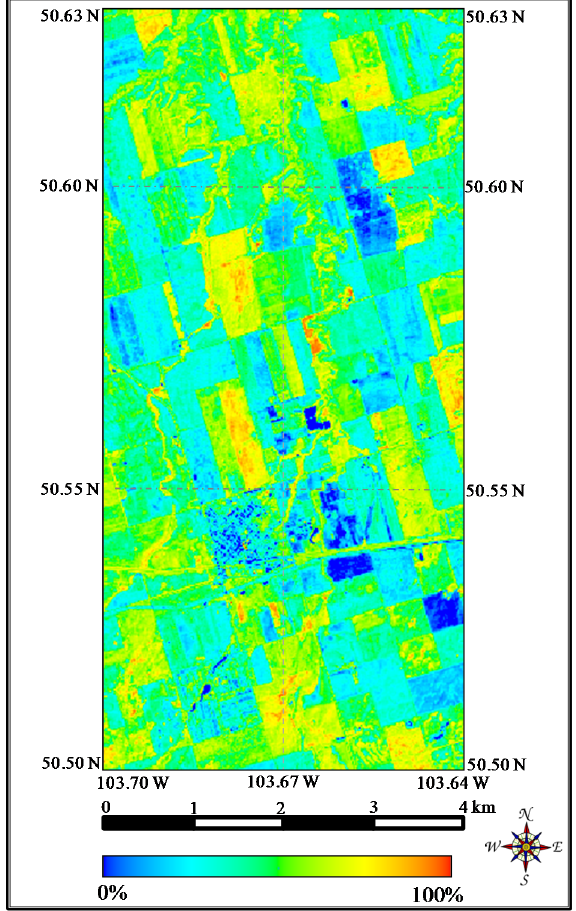
Figure 5. Percent crop residue cover (PCRC) map derived from the Hyperion cube using CLMSA. The fraction map represents the dry and slightly moist